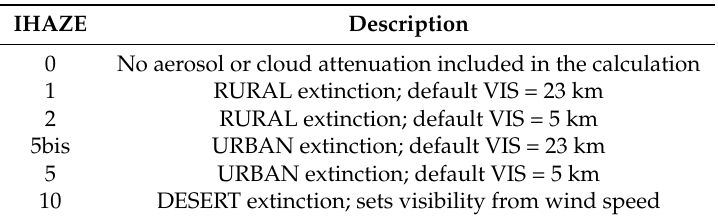
Table 1. Description of MODTRAN default aerosol models that can be used in the site of Maroua. IHAZE is the aerosol model identifier and VIS represents the